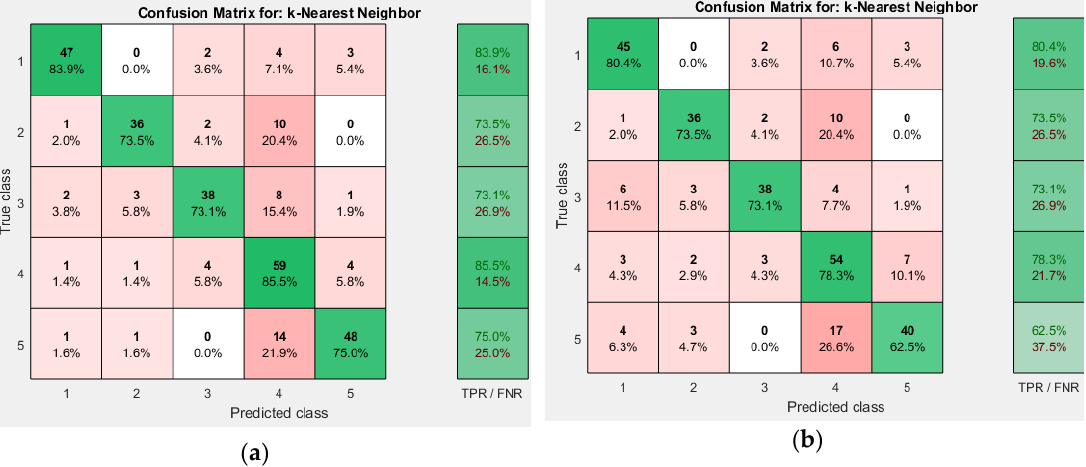
Figure 8. Cosine KNN Confusion Matrix. 5.4. Decision Trees Medium Trees resulted in better accuracy than other two, with 71.7%, while Simple Tree had an accuracy of 62.4% and that of Complex Trees was 71.4%. (a) (b) Figure 9. Decision Tree Confusion Matrix. ( a ) Simple Tree ( b ) Medium Tree.